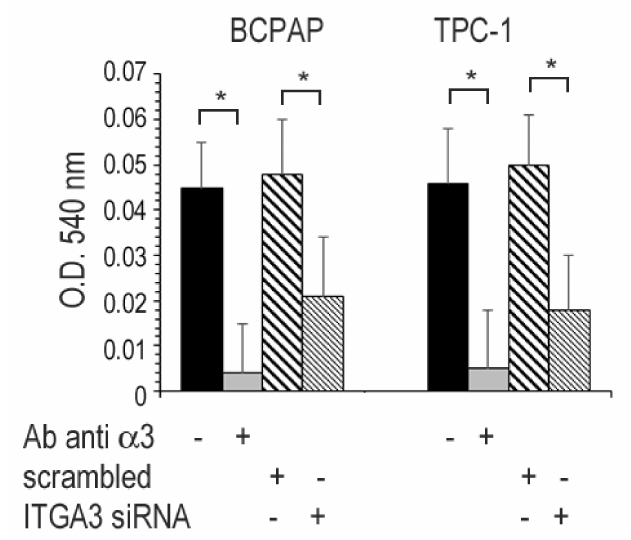
Figure 7. Matrigel invasion assay. Cells were plated on a polycarbonate membrane coated with Matrigel, then cultured for 48 h. The cells on the top of the membrane were carefully removed, and attached cells on the bottom of the membrane stained by crystal violet and measured as described in the Materials and Methods. The cells were incubated with or without Ab anti α 3 integrin subunit or, in separate experiments, the cells were transfected with ITGA3 siRNA or scrambled RNA. All experiments were performed in quadruplicate. *, p <